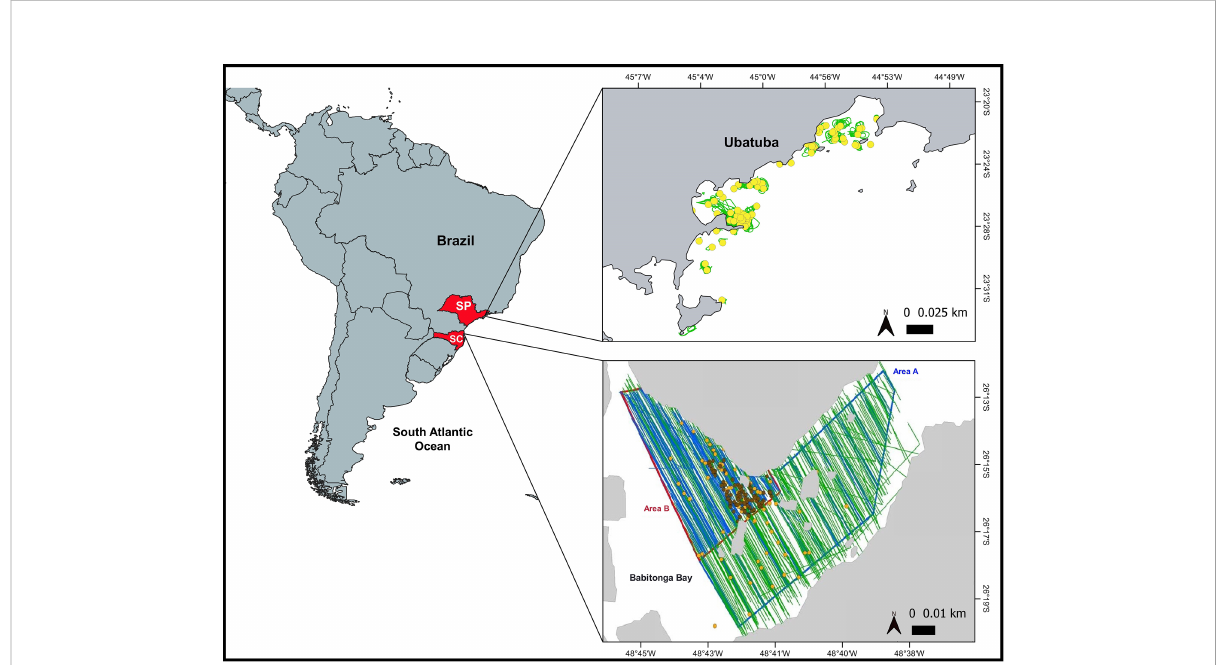
FIGURE 1 Lower map of Babitonga Bay, Santa Catarina State (SC), southern Brazil, showing survey areas A and B, realized trackline effort from aircraft (green lines) and from boats (blue lines), and franciscana sightings for both aircraft (yellow dots) and boats (brown dots); upper map of Ubatuba, São Paulo State (SP), southeastern Brazil, showing realized trackline effort (green lines) and franciscana sightings (yellow dots) from